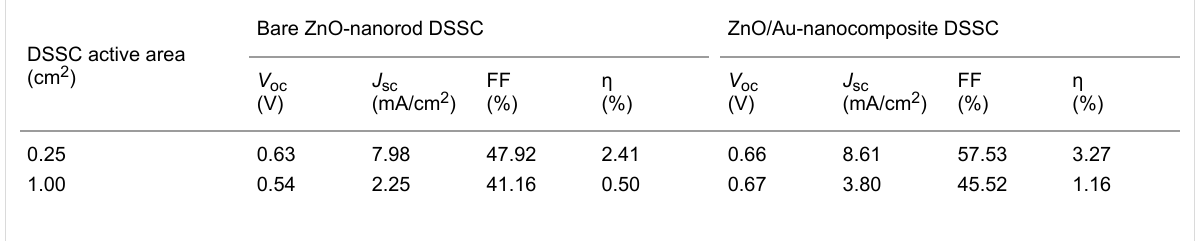
DSSC active area (cm 2 )